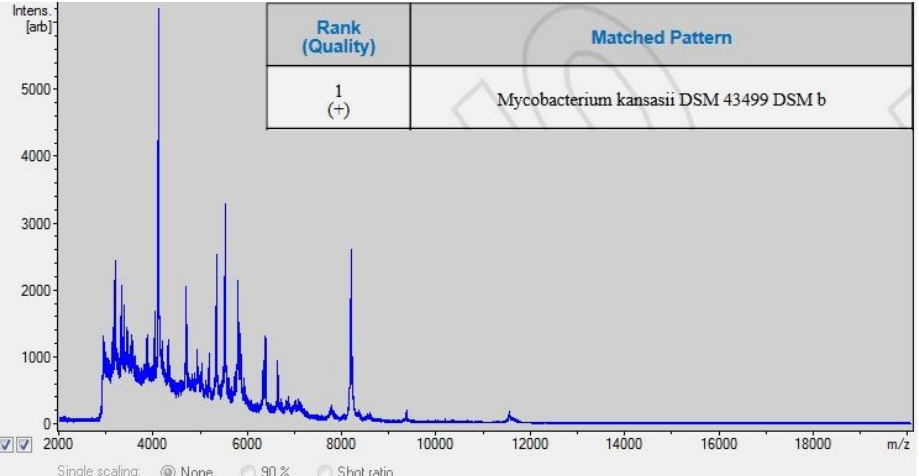
Figure 4. MALDI ‐ TOF results.